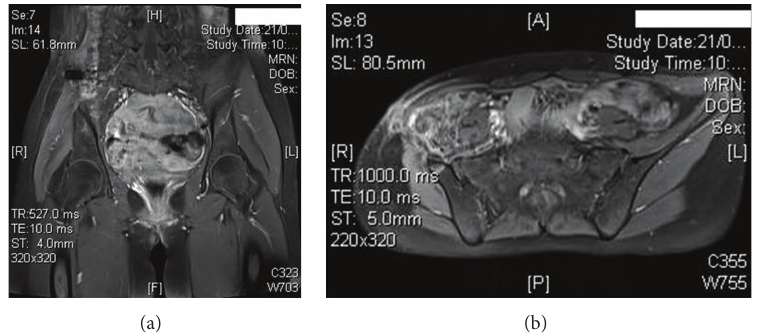
Figure 4: MRI images of the patient showing no evidence of